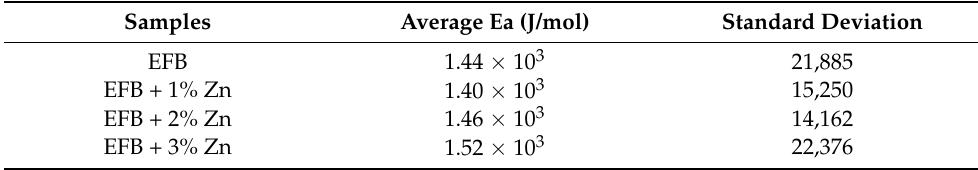
Table 6. Average kinetic energy (Ea) and standard deviation between central conversions (0.3 to 0.8).